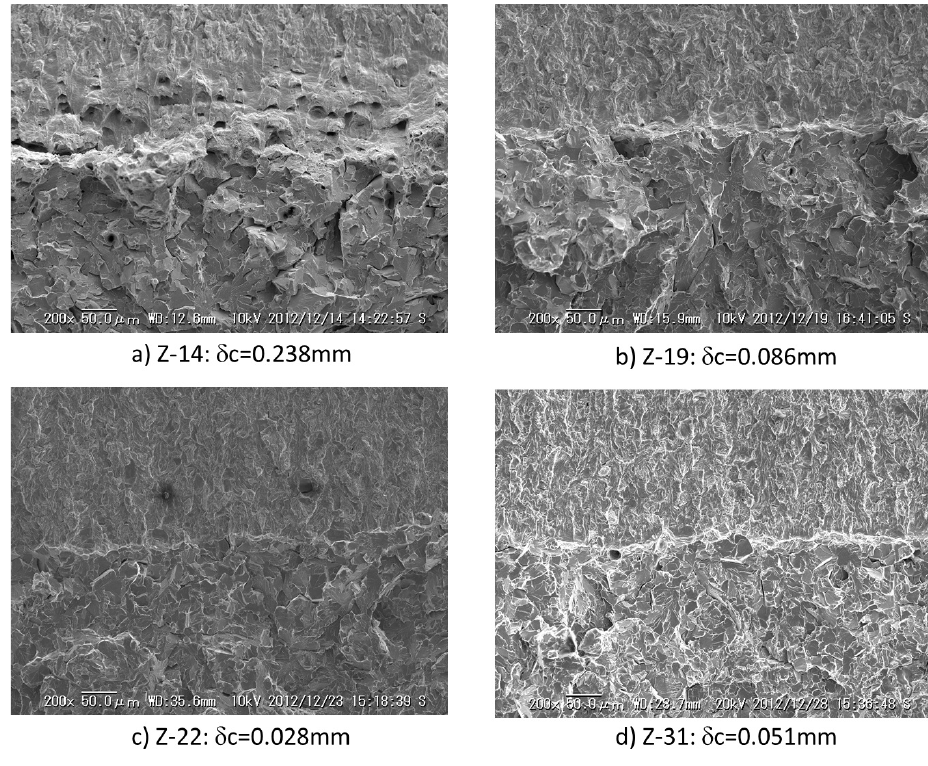
Figure 7. SEM fractography images, showing crack-tip blunting.